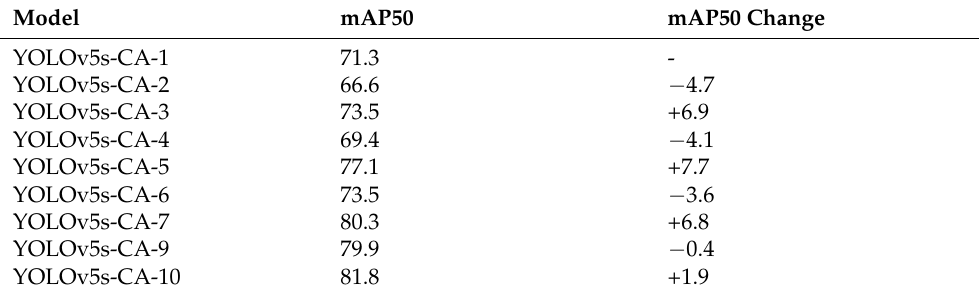
Table 3. Ablation Experiment of the best working position of attention.